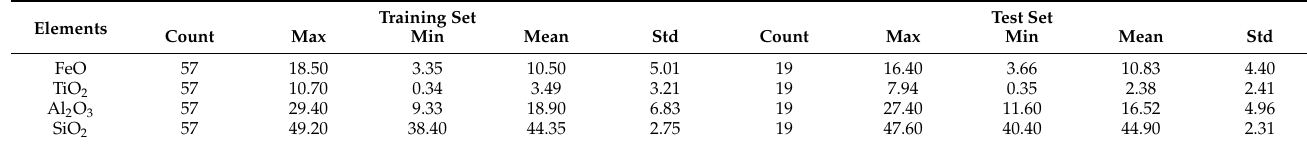
Table 2. Statistical parameters of sample set